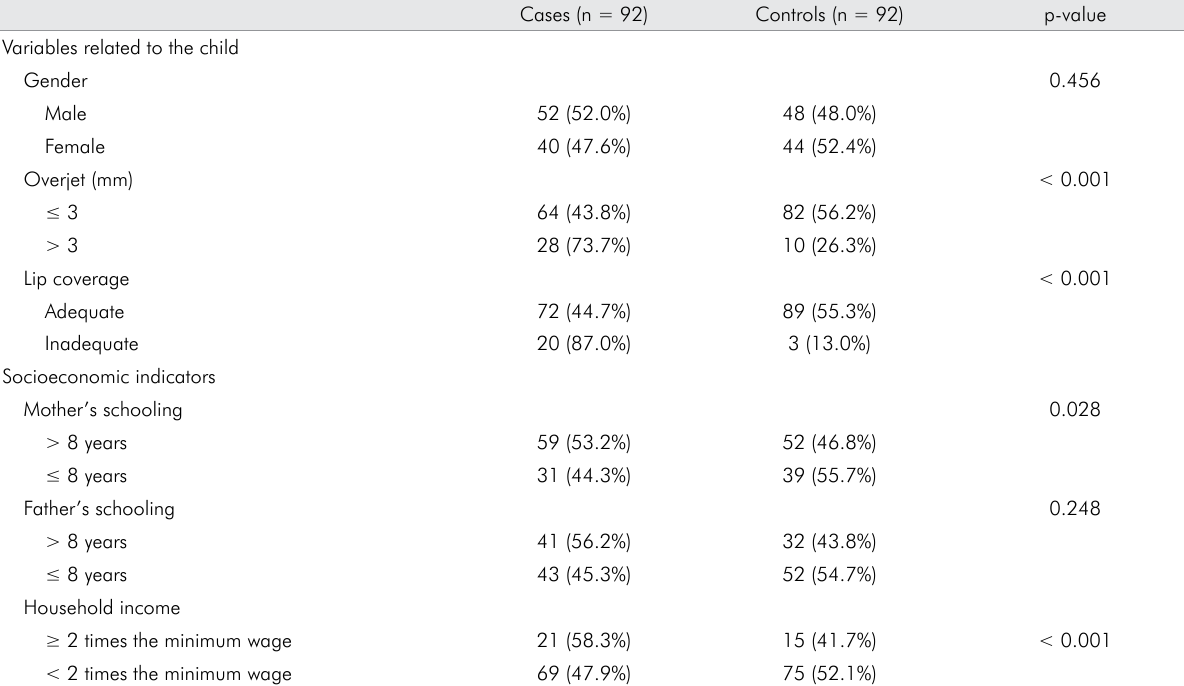
Table 1. Associations between gender, overjet, lip coverage, socioeconomic indicators and TDI among preschool children in Diamantina,